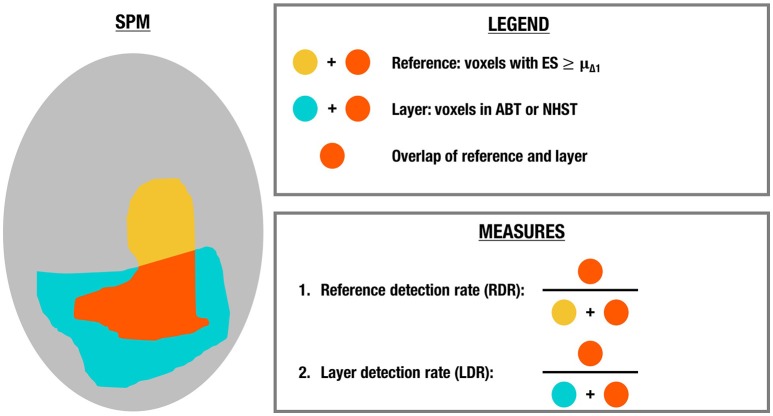
Illustration of the outcome measures in the real data example.